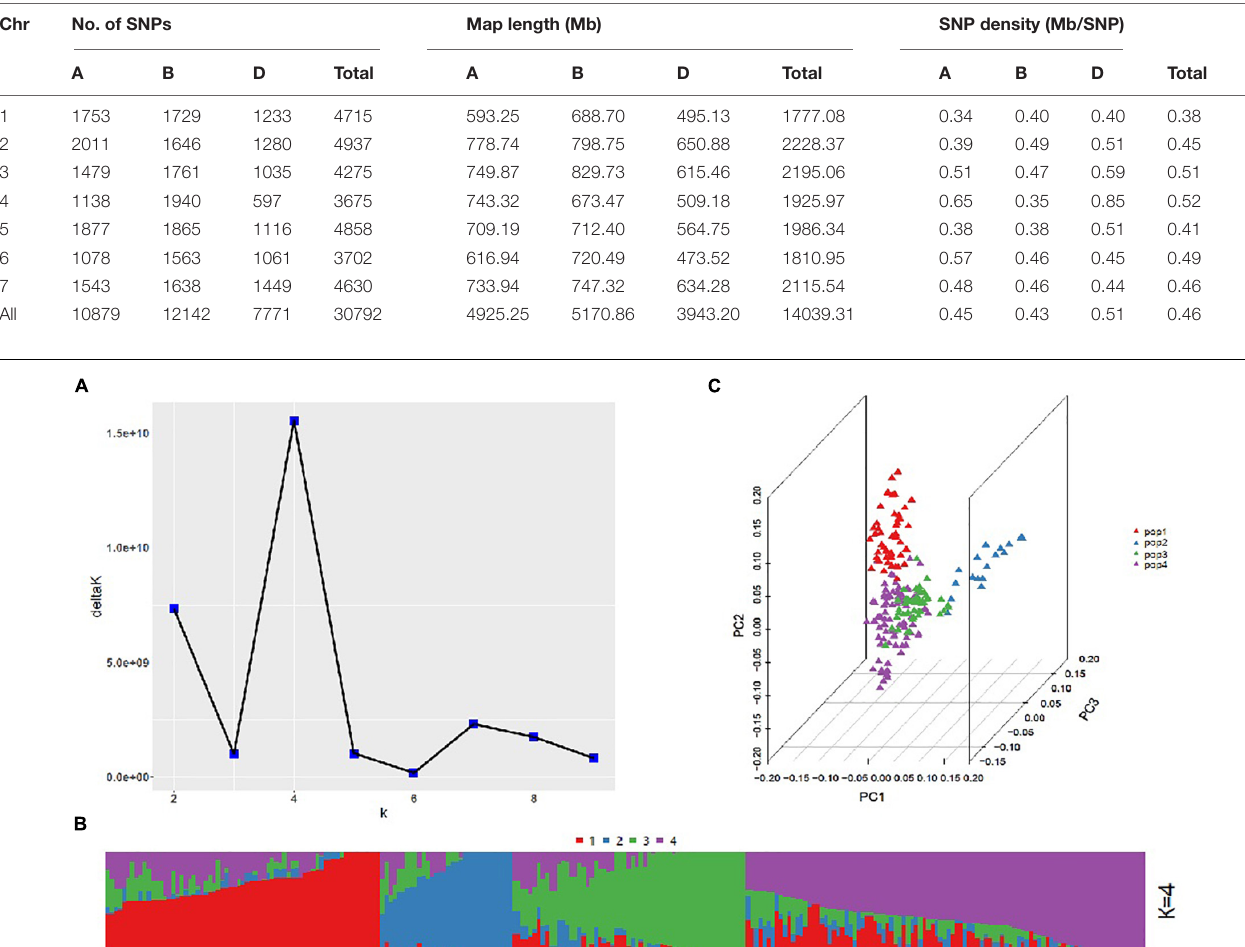
TABLE 1 | SNP marker distribution in the A, B, D, and whole genomes.